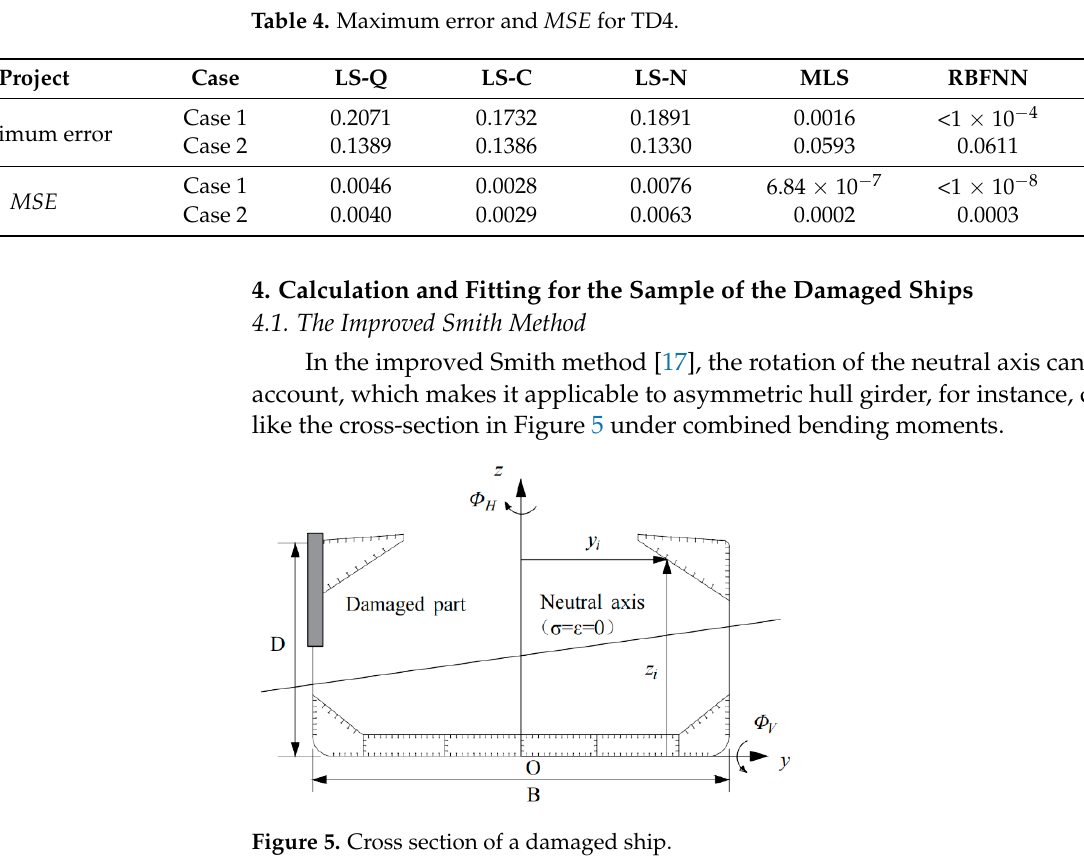
Figure 6. Stress–strain curve.